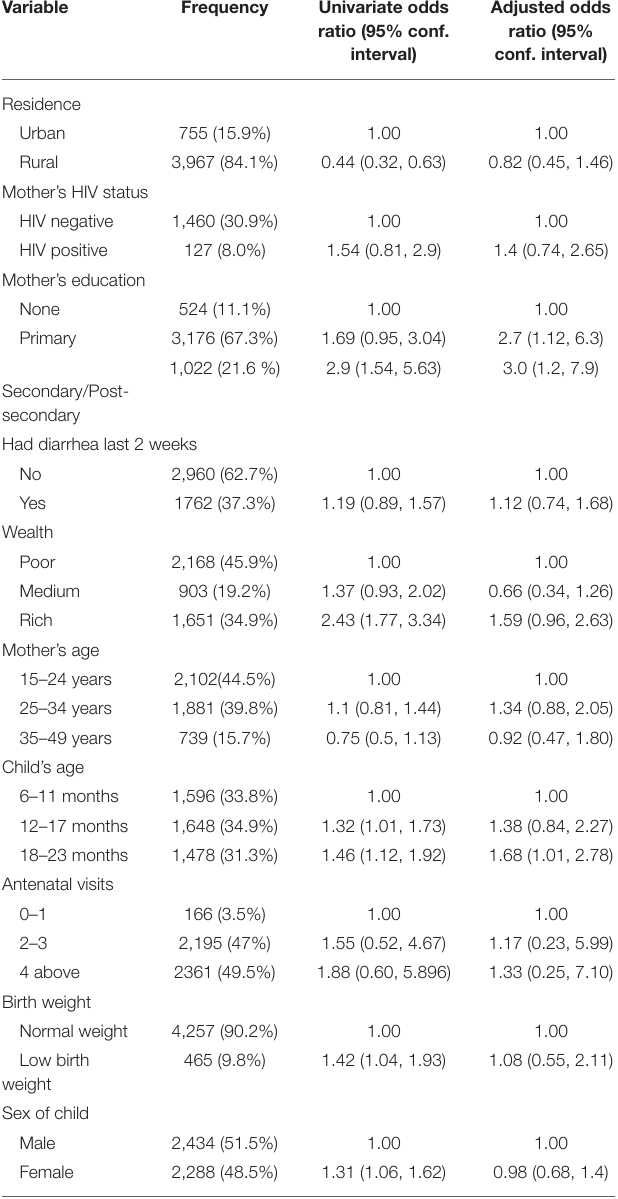
TABLE 3 | Odds ratio (95% Confidence Interval) for the association between provision of appropriate complementary foods and predictors of child growth. Variable